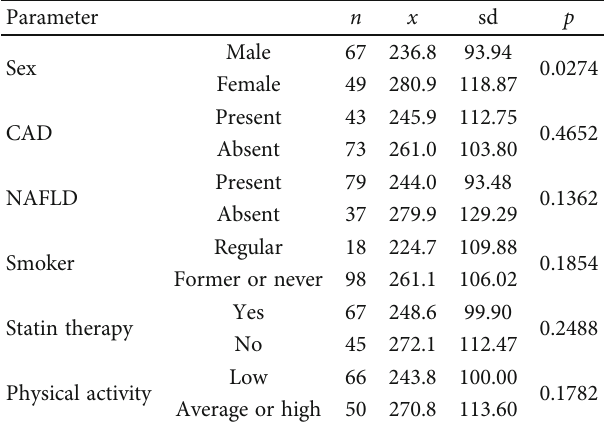
Table 1: Mean values of PCSK9 serum concentrations (ng/ml) in patients with type 2 diabetes mellitus according to sex, CAD, smoking status, statin therapy, and physical